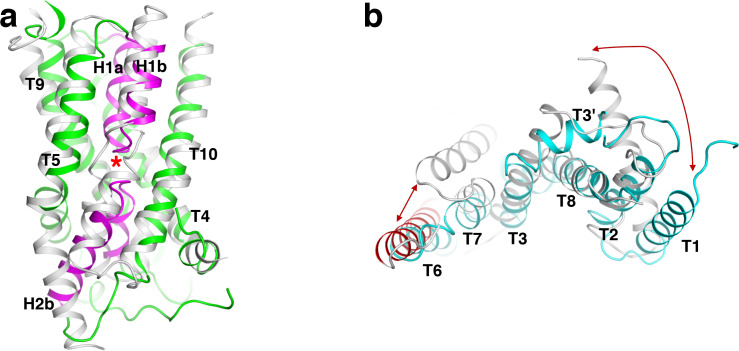
Structural homology between the StOAD β subunit and NapA.(a)-(b) Structural superimposition of the core (a) and scaffold (b) domains in the StOAD β subunit and equivalent regions in the Thermus thermophilus NapA (TtNapA, PDB 5BZ2, colored in gray). The red star in panel (a) indicates the space between the helical hairpin tips. The extra helix in the TtNapA scaffold domain is colored in red in panel (b). The red arrows in panel (b) indicate the large conformational differences between T1, T6 and their equivalents in TtNapA.